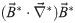
Contours of the three components of the term (B→*·∇→*)B→*.(A) Lateral position (see Fig 1A). (B) Central position. The relative position of the magnet (Lm = 5 mm) with respect to the microchannel (h = 0.1 mm W = 0.5 mm) is indicated by the black lines.